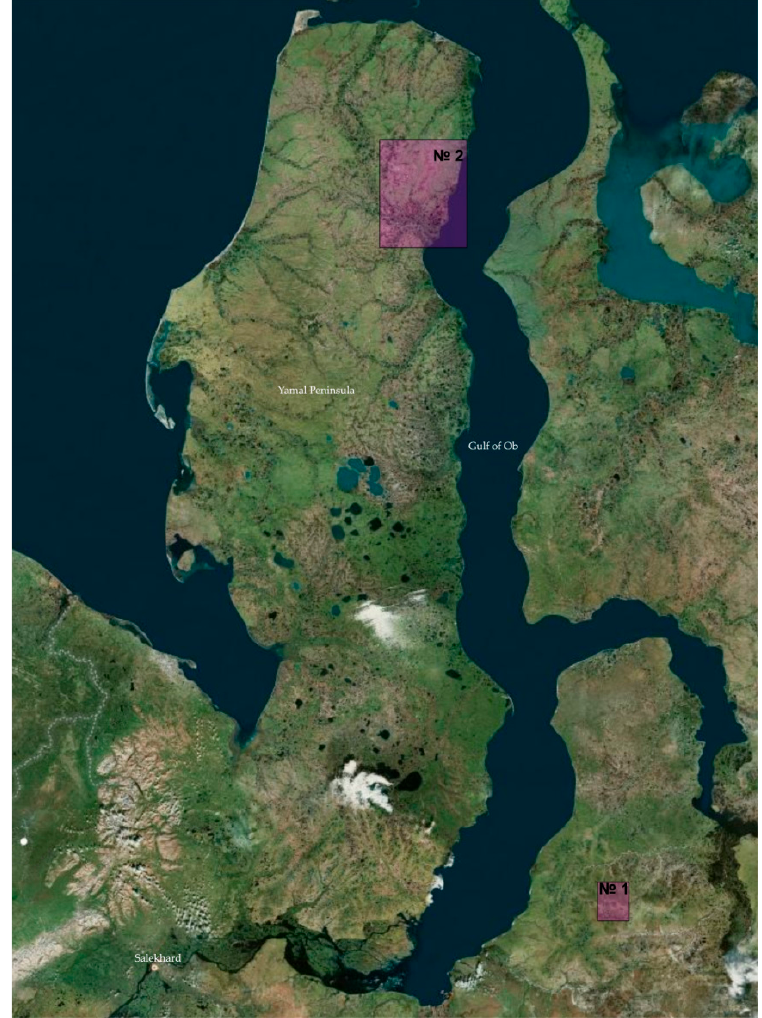
Figure 1. Location of studied sites in a satellite image.